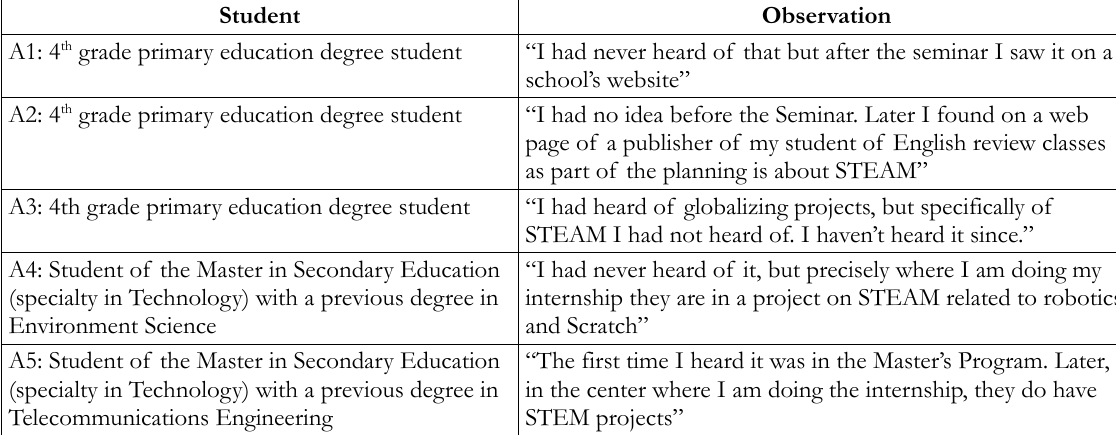
Table 3. Answers related to the category “Previous knowledge about